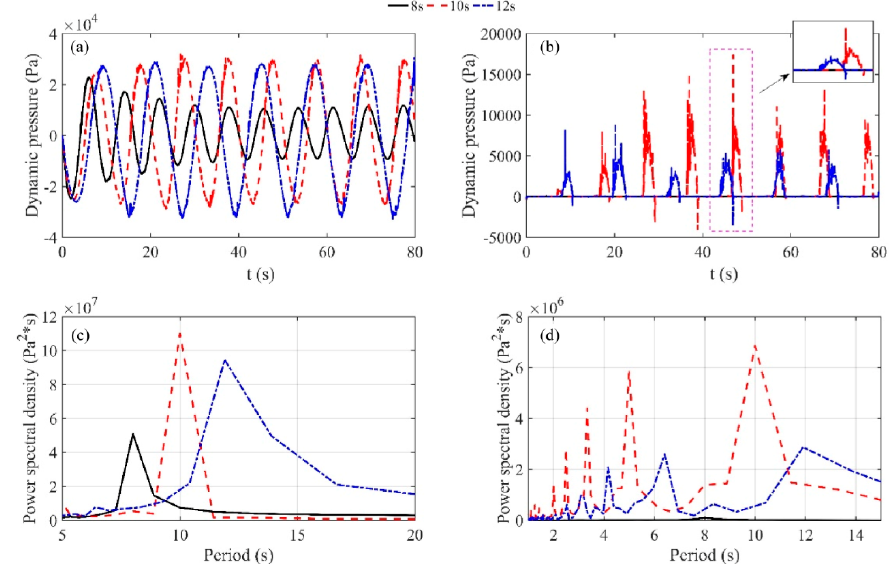
Figure 14. Dynamic pressures for the case of 70% filling of tank height under forcing period 8.0 s (black line), 10.0 s (dash-dot line), and 12.0 s (dash line) at ( a ): P4, ( b ): P5. The corresponding power spectra ( c ) and ( d ).